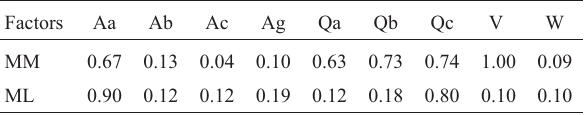
Table 4 - Expected heterozygosity, exclusion probability (%), and Nei’s genetic identity of Mangalarga Marchador (MM) and Mangalarga (ML) breeds for 12 loci.